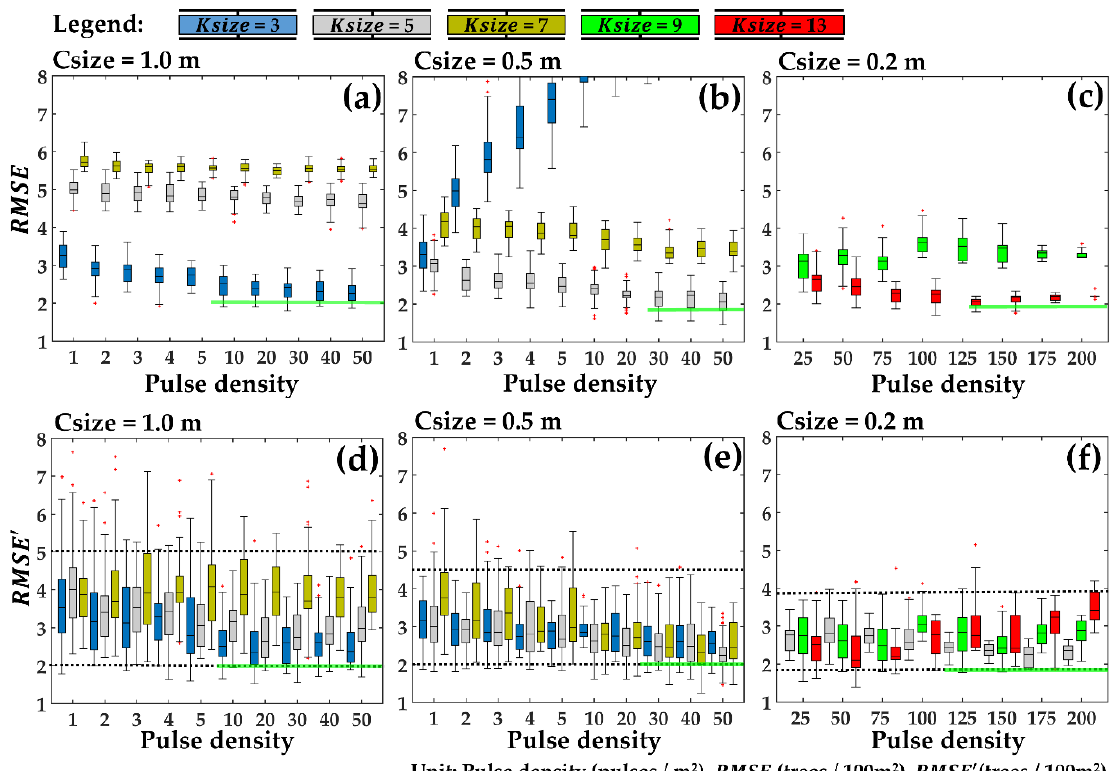
Figure 7. Boxplot distribution of 𝑅𝑀𝑆𝐸 and 𝑅𝑀𝑆𝐸 ′ values under different laser pulse densities, using CHM Fe as the example. ( a ) Boxplot distribution of 𝑅𝑀𝑆𝐸 values at Csize = 1 m; ( b ) Boxplot distribution of 𝑅𝑀𝑆𝐸 values at Csize = 0.5 m; ( c ) Boxplot distribution of 𝑅𝑀𝑆𝐸 values at Csize = 0.2 m; ( d ) Boxplot distribution of 𝑅𝑀𝑆𝐸 ′ values at Csize = 1 m; ( e ) Boxplot distribution of 𝑅𝑀𝑆𝐸 ′ values at Csize = 0.5 m; ( f ) Boxplot distribution of 𝑅𝑀𝑆𝐸 ′ values at Csize = 0.2 m. The black dotted line indicates the distribution range of 𝑅𝑀𝑆𝐸 ′ .